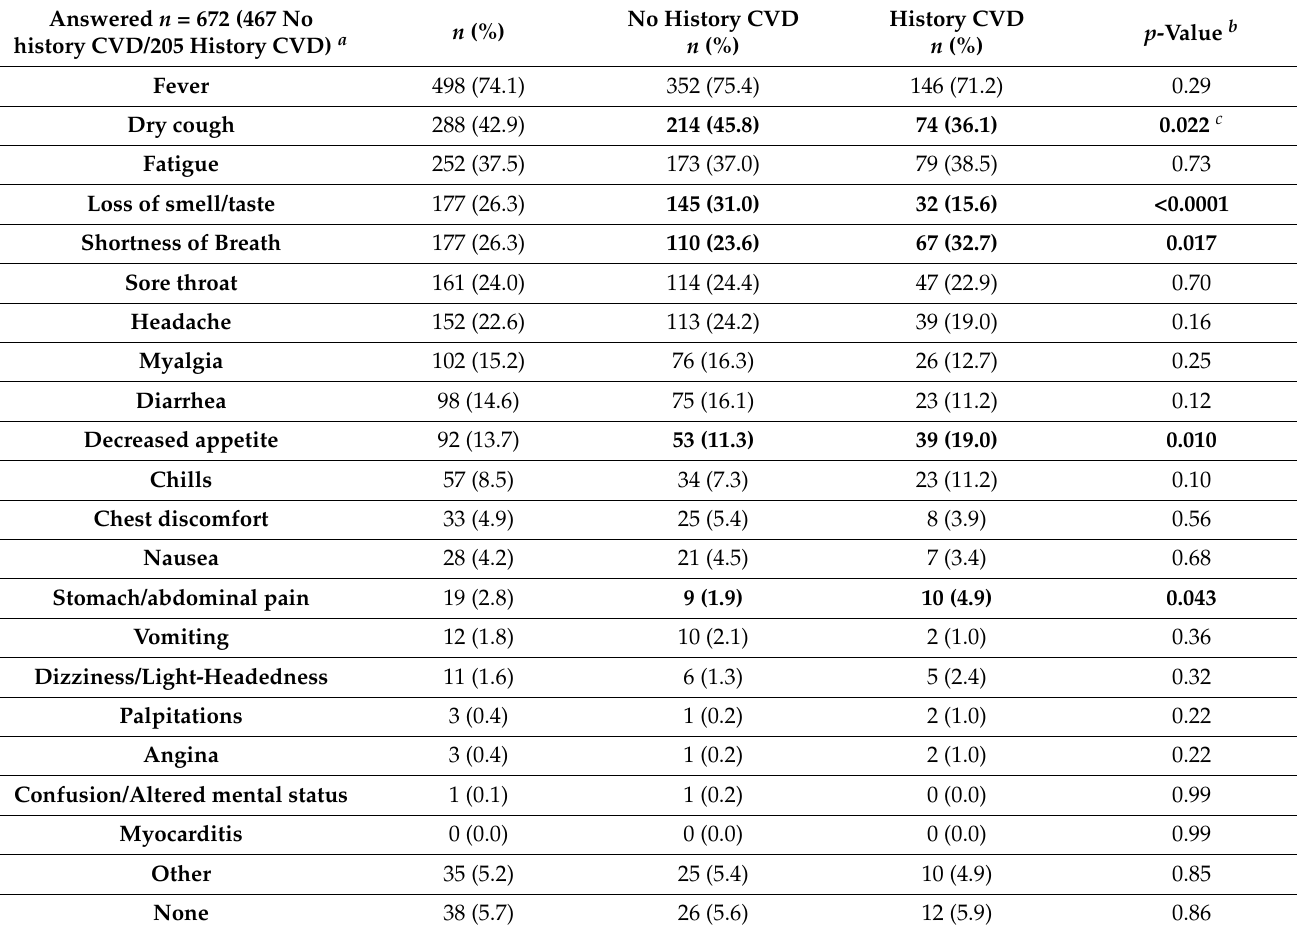
Table 2. COVID-19 symptoms and outcomes for patients in registry with or without history of